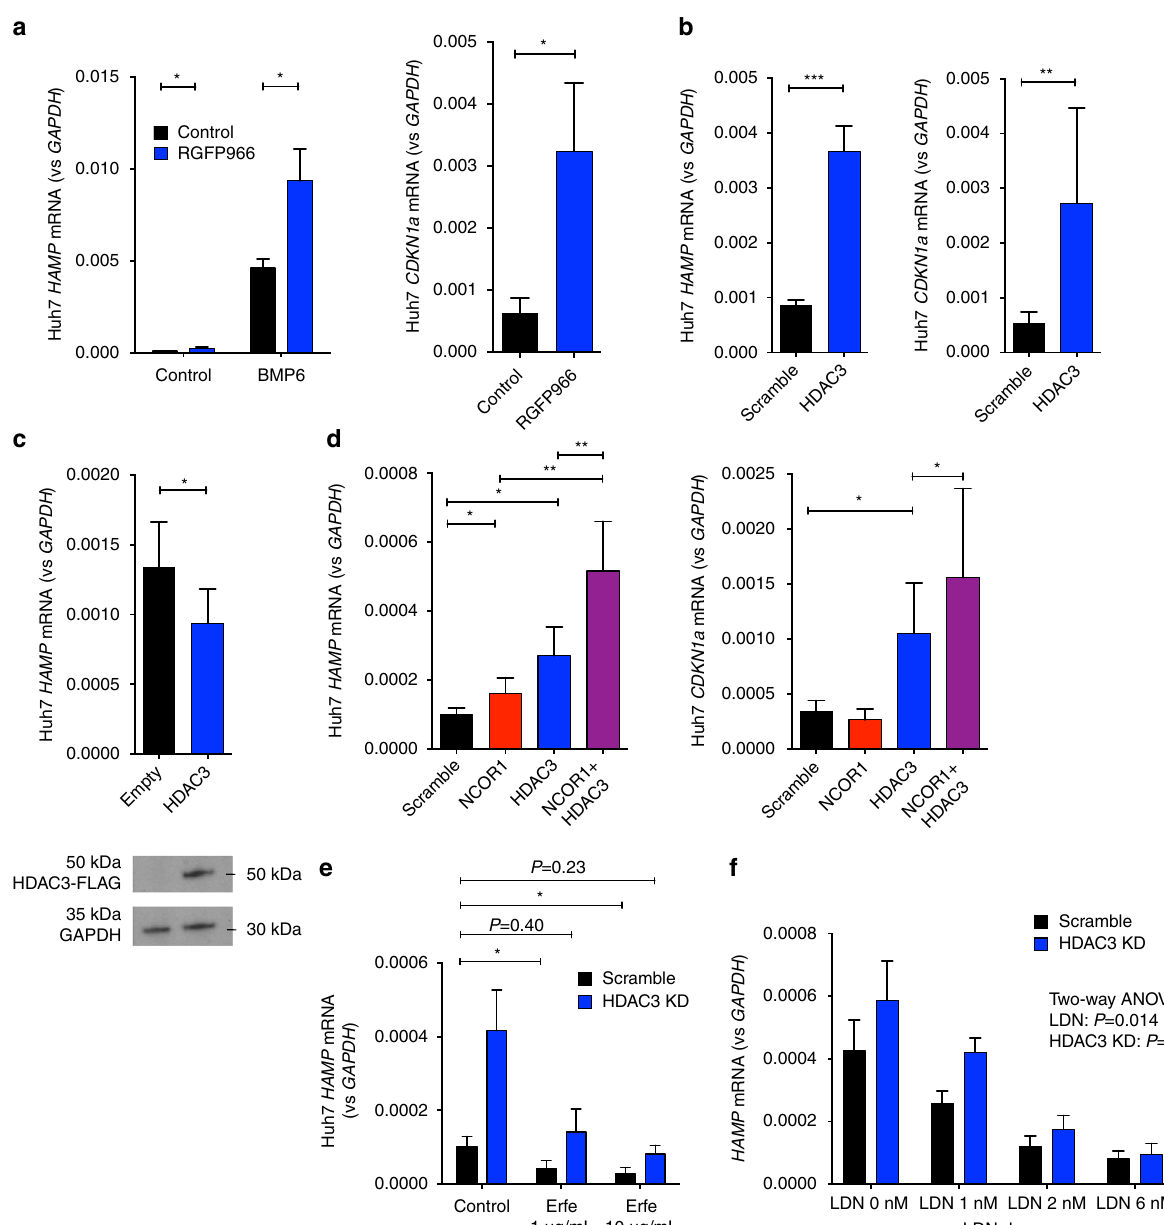
Fig. 7 Effects of HDAC3 inhibition on hepcidin expression. Effects of treatment of Huh7 cells with RGFP966 10 µ M on a HAMP ( n = 6 separate experiments, paired t -test) and CDKN1A mRNA expression ( n = 6 separate experiments, paired t -test). b Effect of knockdown of HDAC3 (using 100 nM siRNA) on HAMP and CDKN1A mRNA expression ( n = 6 separate experiments, paired t -test). c Effects of overexpression of HDAC3 on HAMP mRNA expression ( n = 5 separate experiments, paired t -test). Western blot for FLAG at 50 kDA (molecular weight of HDAC3). d Effects of single knockdown of HDAC3 and NCOR1 (using 50 nM siRNA) or double knockdown of HDAC3 + NCOR1 (50 nM each) on HAMP1 and CDKN1A mRNA expression, n = 6 replicates, ratio paired t -tests. e Effects of erythroferrone treatment in Huh7 cells with and without concurrent HDAC3 knockdown on HAMP mRNA expression, n = 3 separate experiments, comparing scramble + vehicle with HDAC3 knockdown + Erfe (1 or 10 µ g/ml) (two-way ANOVA for effects of HDAC3 and Erfe, paired t -tests for speci fi c comparisons of interest). f Effects in Huh7 cells of LDN titrations (control, 1, 2, and 6 nM) with and without concurrent HDAC3 knockdown on HAMP mRNA expression, n = 6 separate experiments, two-way ANOVA for effects of LDN and HDAC3. Data are means ± s.e.m. * P ≤ 0.05; ** P ≤ 0.01; *** P ≤ 0.001; **** P ≤ 0.0001; NS, P > mouse liver slices (PCLS) in vitro, in which liver cellular human hepatoma-derived cell line to evaluate the effects of PB on architecture is preserved 36 but effects of systemic iron status and hepatocytes alone in culture. PB treatment of hepatocyte-derived erythropoiesis are eliminated. PCLSs were treated with increasing Huh7 hepatoma cells increased HAMP expression at baseline and doses of PB and human BMP9, which we found to best increase also potentiated the increase of HAMP produced by exogenous Hamp1 and Id1 mRNA expression in this model (Supplementary recombinant BMP6 (Fig. 6b, c; Supplementary Fig. 5b). These Fig. 5a). BMP9 increased Hamp1 mRNA and PB enhanced this effects of PB on HAMP expression were likely independent of effect on Hamp1 expression (Fig. 6a). Next, we used the Huh7 changes in BMP signaling, because PB did not alter baseline